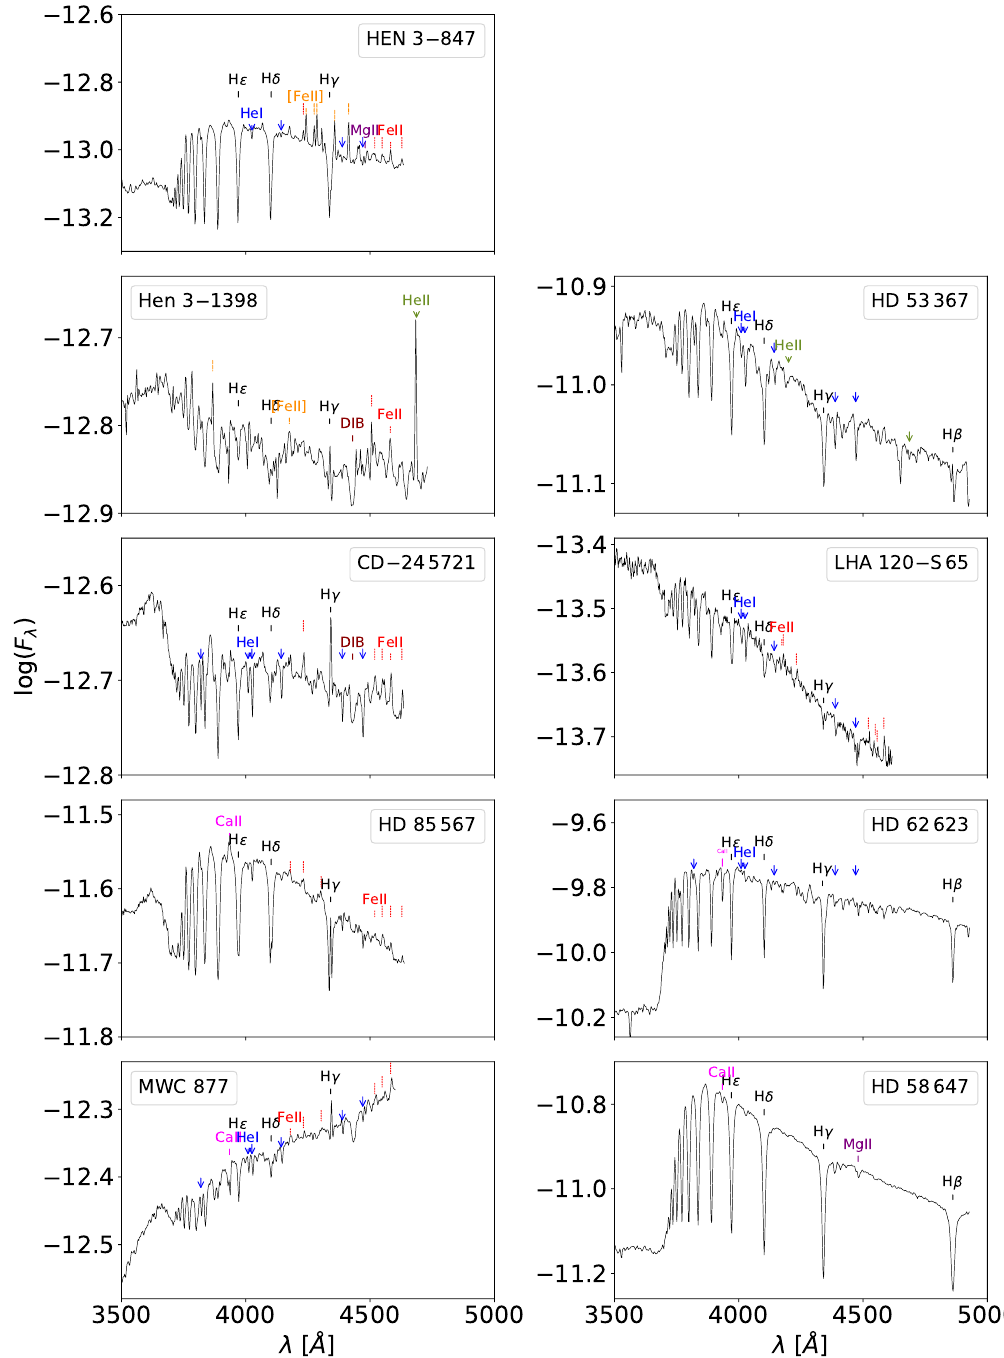
Figure 14. Examples of energy distributions of B[e] stars with a second component of the BD in which some spectral line identifications are shown. The spectra were observed at CASLEO, Argentina. Figure adapted from Aidelman et al.